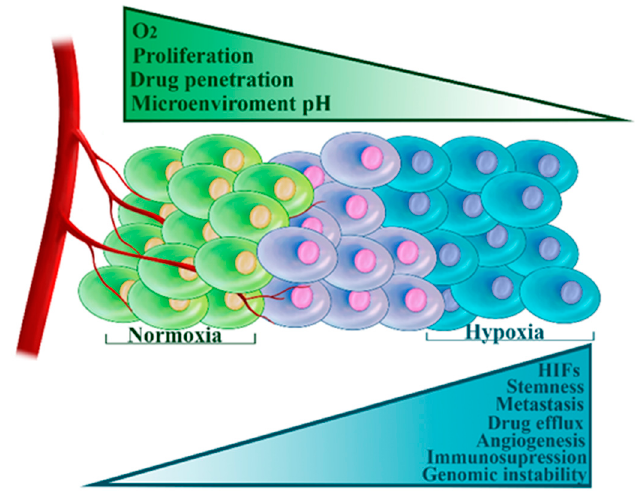
Figure 3. Role of hypoxia in tumor chemoresistance. Hypoxia induces numerous mechanisms that interfere with cytotoxic drugs and hinder their success.